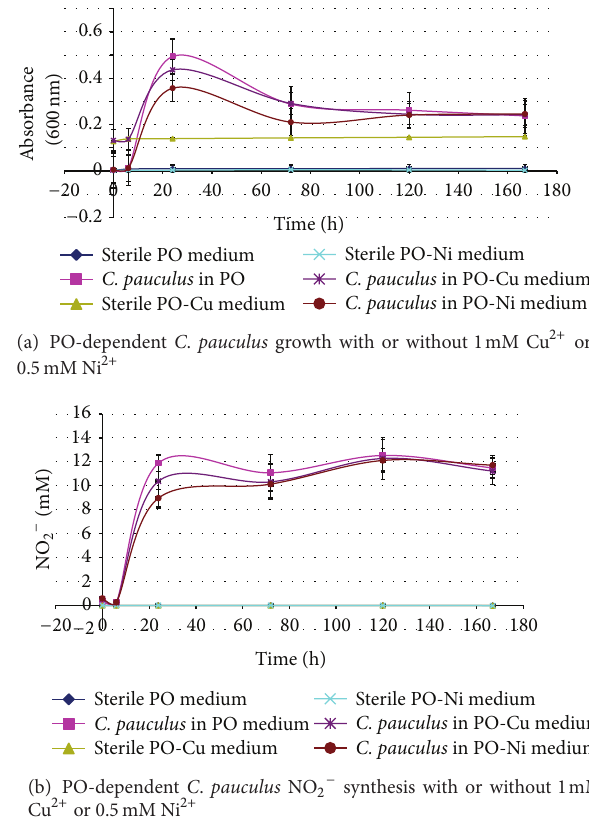
Figure 2: Growth (a) and nitrification (b) of C. pauculus UM1 in PO-mineral salts medium with or without either 1.0mM Cu 2+ or 0.5 mM Ni 2+ .(Theinoculumforthecultureswasgrownin0.2%PO-mineralsaltsmediumuntilmid-to-latelogarithmicgrowthandusedat0.5%(v/v). The growth curves for C. pauculus UM1 either with 1.0 mM Cu 2+ ( 𝑃 ≤ 0.05 ) or 0.5 mM Ni 2+ ( 𝑃 ≤ 0.01 ) or without Cu 2+ or Ni 2+ ( 𝑃 ≤ 0.01 ) were significantly different from their corresponding uninoculated controls. Similarly, the NO 2− synthesis curves either with 1.0mM Cu 2+ , 0.5 mM Ni 2+ or without either Cu 2+ or Ni 2+ were significantly different ( 𝑃 ≤ 0.01 ) from their corresponding uninoculated controls. At the 𝑇 = 24 and 72 hours, growth of all inoculated C. pauculus UM1 cultures was significantly different ( 𝑃 ≤ 0.01 ) than the corresponding uninoculated controls. In addition, at 𝑇 = 120 and 167 hours, C. pauculus UM1 cultures grown either without Cu 2+ or Ni 2+ or with 0.5 mM Ni 2+ were significantly different ( 𝑃 ≤ 0.01 ) than their corresponding uninoculated controls. At 𝑇 = 24 hours, the growth of C. pauculus UM1 with 0.5 mM Ni 2+ was significantly less ( 𝑃 ≤ 0.01 ) than C. pauculus UM1 grown without Cu 2+ or Ni 2+ . At 𝑇 = 120 and 167 hours, the growth of all C. pauculus UM1 cultures was not significantly different than the uninoculated 1mM Cu 2+ control. At all measurements, NO 2− concentrations were significantly different ( 𝑃 ≤ 0.01 ) between the inoculated cultures and their corresponding uninoculated controls. It is presumed that, at the early time points ( 𝑇 = 0 and perhaps 6 hours), this was due to NO 2− carryover with the inocula. At 𝑇 = 24 hours, NO 2− concentrations were significantly different ( 𝑃 ≤ 0.05 ) between the inoculated PO-0.5 mM Ni + cultures and inoculated PO cultures without either Cu 2+ or Ni 2+ .) Error bars represent the standard deviation of a